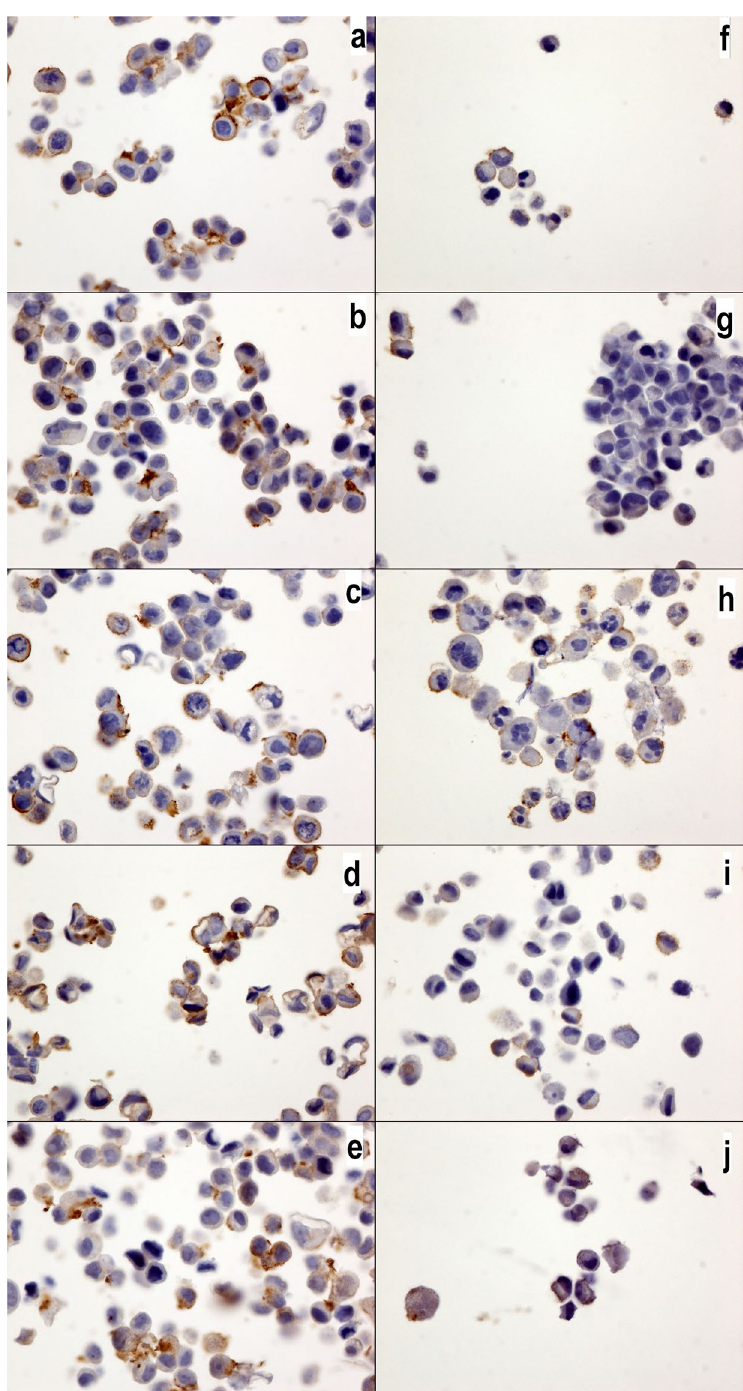
Figure 8. IL17RB expression in MCF7 and MDA-MB231 cells. IL17RB expression in MCF7 ( a – e ) and MDA-MB231 cells ( f – j ) without drugs or ( a , f ) with cyclophosphamide ( b , g ), doxorubicin ( c , h ), epirubicin ( d , i ) or 5-fluorouracil ( e , j ). All cells cultures exhibited a positive membrane signal, but no changes were observed with the chemotherapy drug treatments. Note that the MCF7 cells show a higher expression than the MBA-MB231 cells. The IL17RB antibody was diluted 1/40 (40x